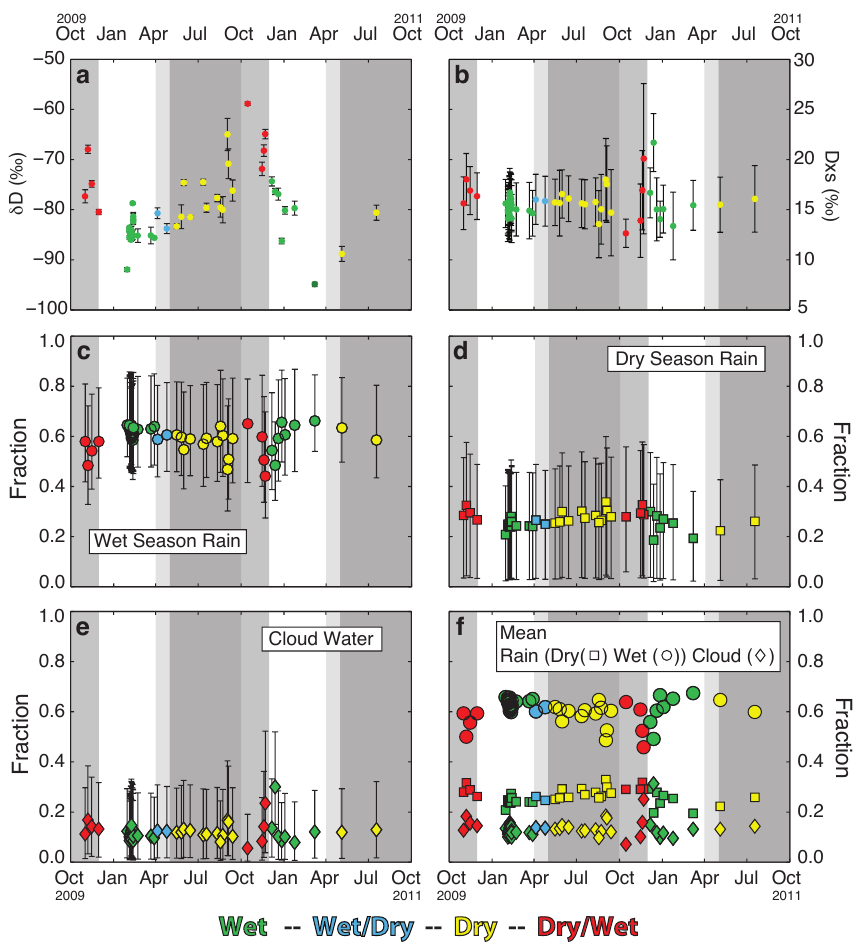
Figure 6. Time series of river water hydrogen isotopes ( δD river ) and river water deuterium excess (Dxs river ), and the calculated mixing proportions of different sources for the Kosñipata River. (a) The time series of δD river values with error bars signifying 2 standard deviations. (b) The time series of Dxs river values with error bars signifying 2 standard deviations. Time series of the 5th (lower error bar), 50th (open circle), and 95th percentile (upper error bar) values of the distribution of fractional contributions to river discharge, calculated using the three- endmember mixing model, of (c) wet-season rain; (d) dry-season rain; and (e) cloud water vapour. (f) Time series of the mean